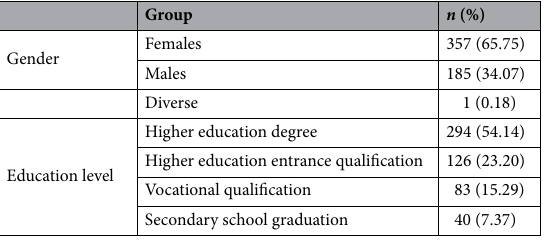
Table 1. Participant